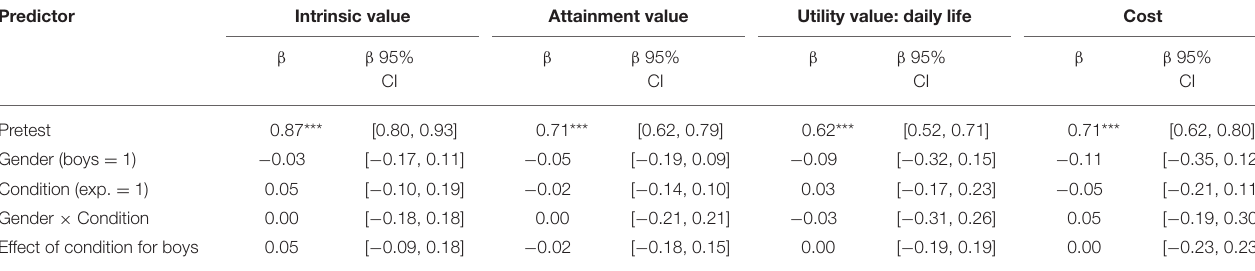
TABLE 6 | Multiple regression models 2: effects on intrinsic value, attainment value, utility value for daily life, and cost. Predictor